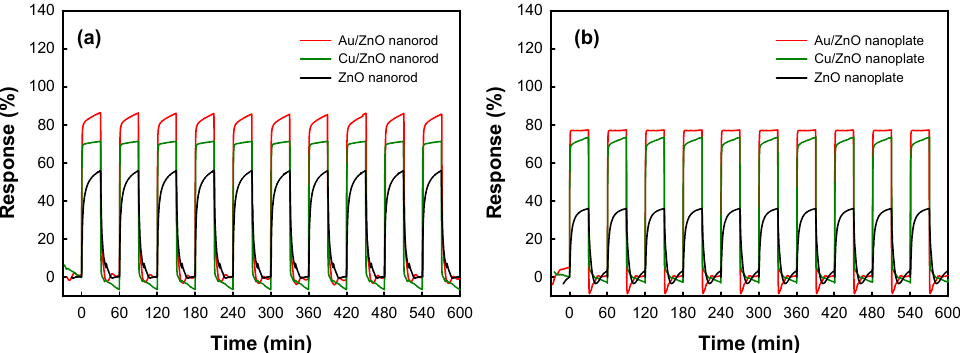
Figure 9. Gas response of the ZnO nanostructure and metal deposited ZnO nanostructures during 10 successive cycles of exposure to 100 ppm CO and air alternately at 200 °C. ( a ) ZnO nanorod and metal- deposited ZnO nanorods ( b ) ZnO nanoplate and metal-deposited ZnO nanoplates. The reproducibility test was also carried out using metal-deposited ZnO nanostructures and pristine ZnO nanostructures under the reversible exposure to 100 ppm CO gas at 200 °C as shown in Figure 9. It was found that the response, response time, and recovery time of the metal-deposited ZnO nanostructures were almost identical during 10 reversible cycles. As shown in Figure 10, we also investigated the change of chemical state of metal in the metal-deposited ZnO nanostructures after 10 successive cycles of exposure to 100 ppm CO gas. Au 4f and Cu 2p spectra of samples before and after gas-sensing test did not show any prominent difference, reflecting that there was no change in the chemical state of Au and Cu nanoparticles after gas-sensing test. Those results would also indicate that the metal-deposited ZnO nanostructures have good stability.